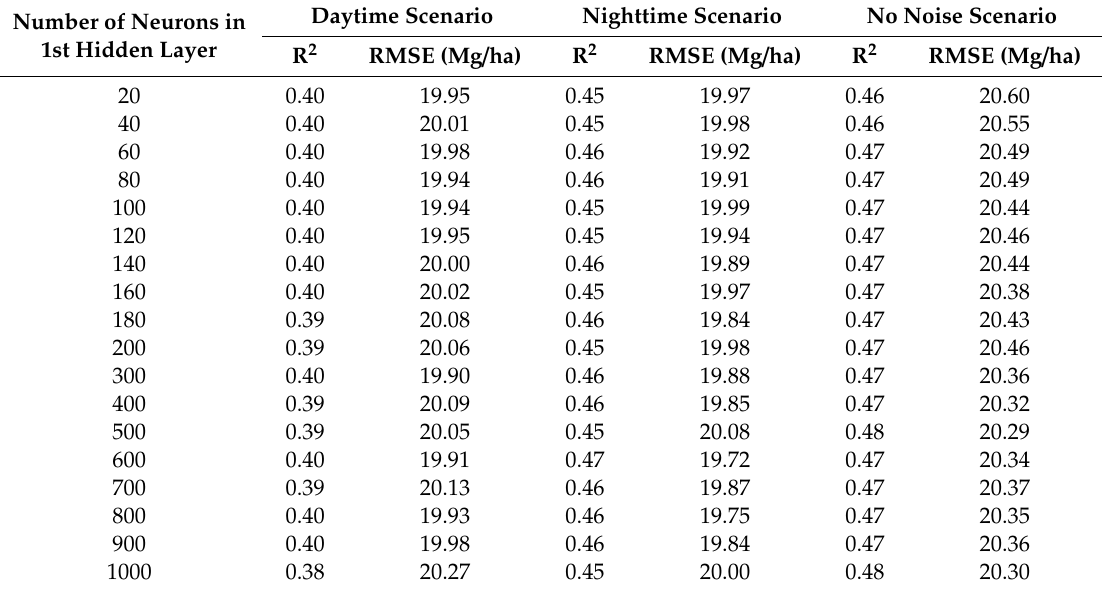
Table 1. Model performance with di ff erent number of neurons in the first hidden layer. For the model with the lowest RMSE in each scenario, a second dense hidden layer was